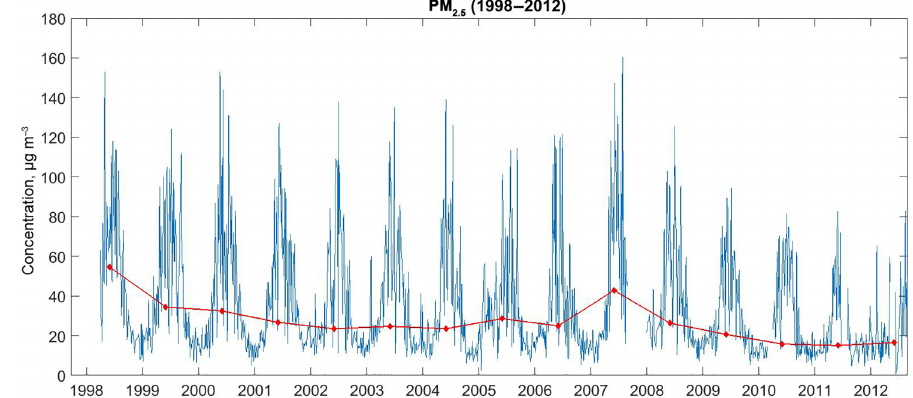
Figure 3. Temporal evolution of PM 2 . 5 concentrations in Parque O’Higgins monitoring station in central Santiago. The red line shows the annual median. Table 3. Seasonal PM 2 . 5 and source contribution identified by a stratified regression of the contributions obtained by PMF 5.0. The con- centration values are given in micrograms per cubic meter (µgm − 3 ) for each season and source, with corresponding standard errors at 95% confidence level within the brackets. The 24h Chilean standard for PM 2 . 5 is 50µgm − 3 and the WHO guidelines is 25µgm − 3